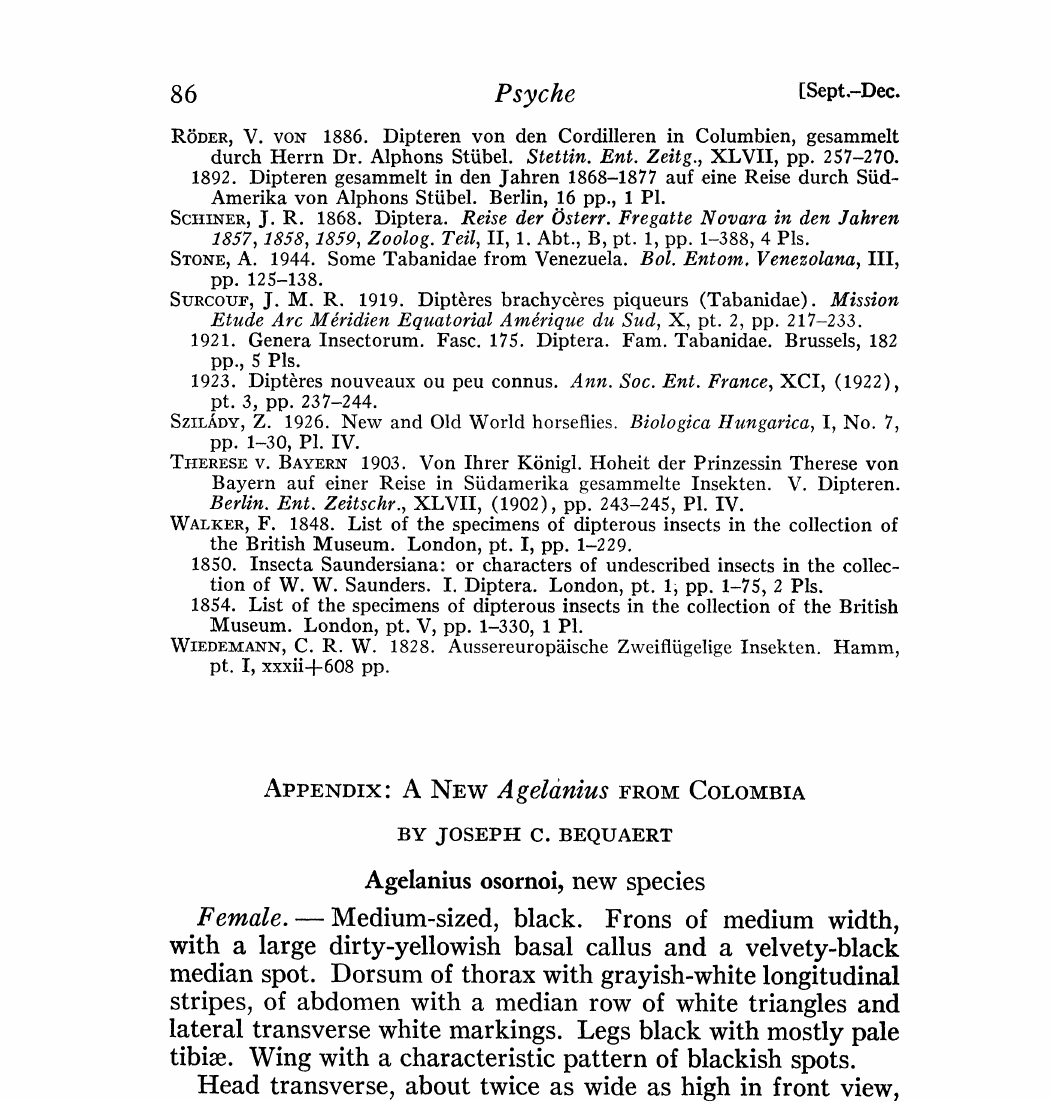
lateral transverse white markings. Legs black with mostly pale tibiae. Wing with a characteristic pattern of blackish